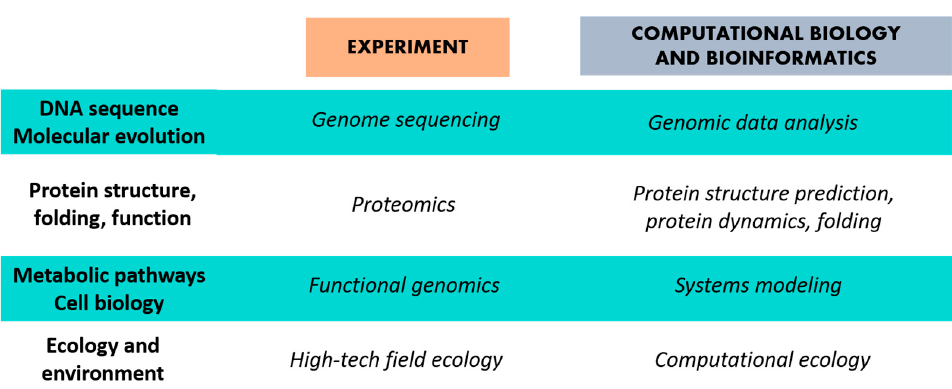
Figure 4. Possibilities of information methods in biology. Figure is adapted from Gibas and Jambeck [85].